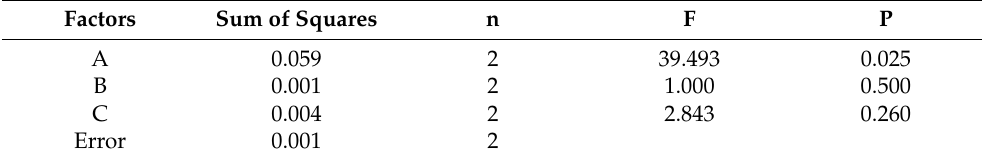
Table 3. ANOVA results of the orthogonal test.